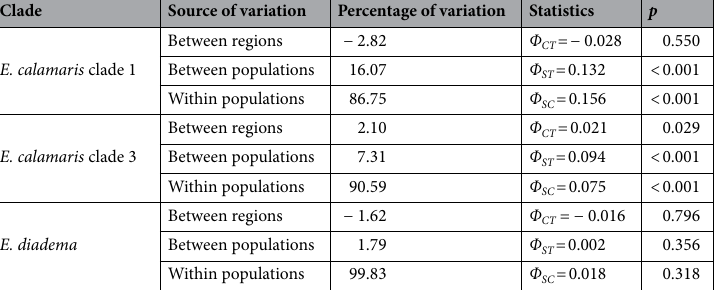
Table 3. AMOVA based on nDNA Tamura and Nei 31 distances comparing differentiation between and within